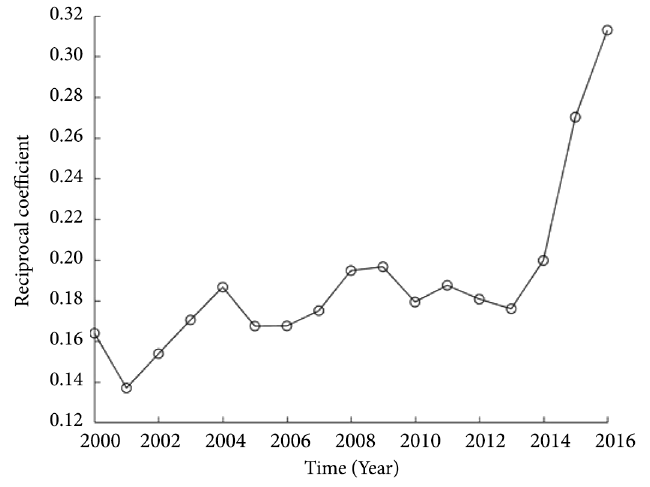
Figure 9. Reciprocal coefficient curve from 2000 to